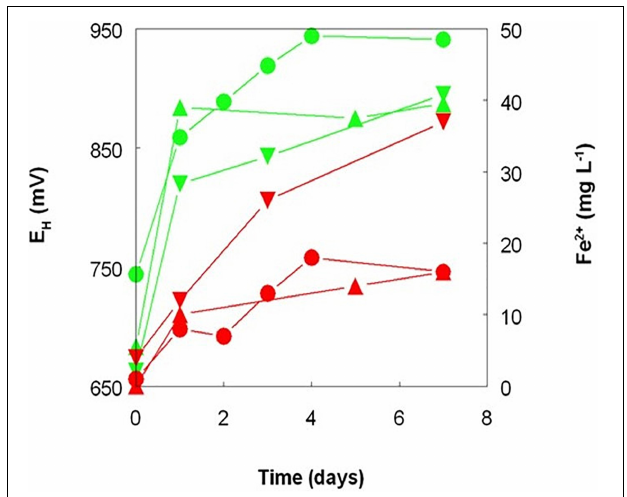
FIGURE 4 | Changes in redox potentials (green symbols) and concentrations of ferrous iron (red symbols) during leaching of New Caledonian limonite at 50 ◦ C and pH 1.0, in the presence of sterile sulfur powder ( (cid:78) , (cid:78) ), bio-ZVS ( (cid:72) , (cid:72) ), and no added sulfur ( , (cid:32) (cid:32)